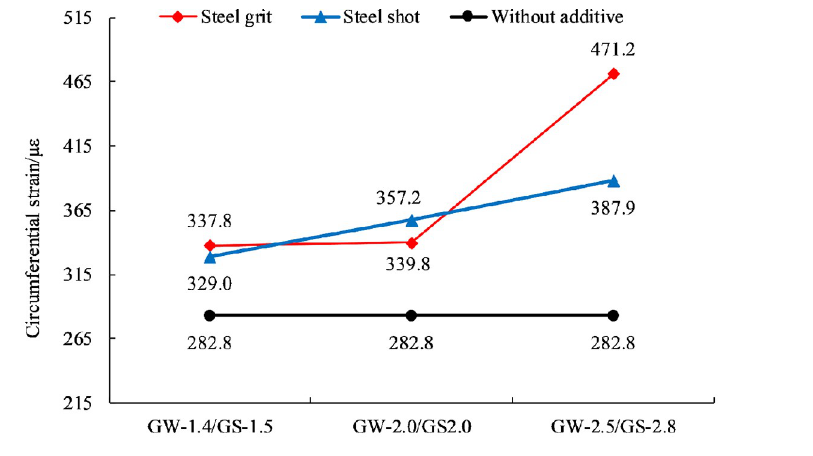
Fig 22. Effect of aggregate shape on circumferential